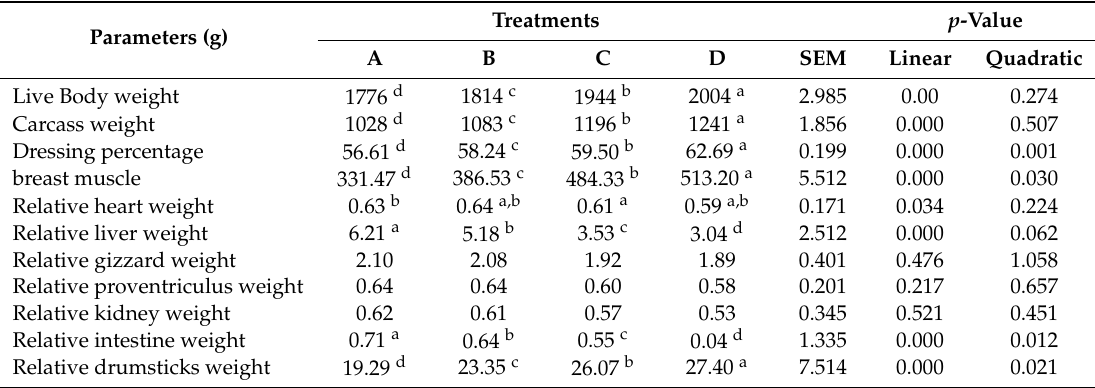
Table 4. E ff ect of biodegradation agent supplementation on carcass characteristics of broilers ( n =